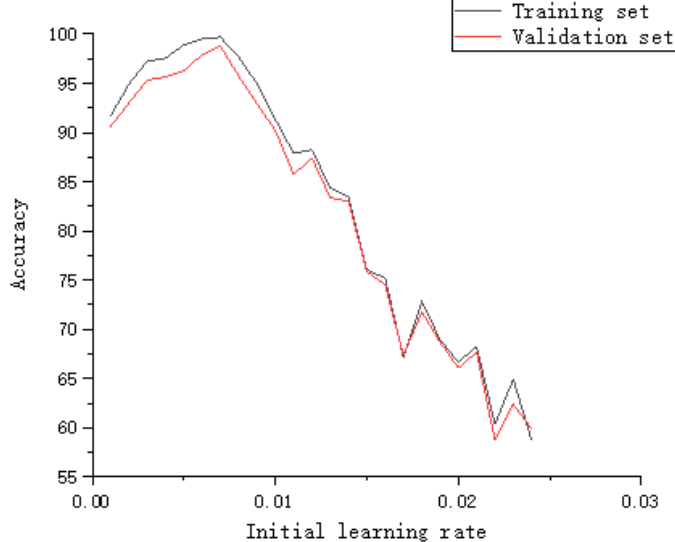
Figure 11. Accuracy corresponding to different learning rates.